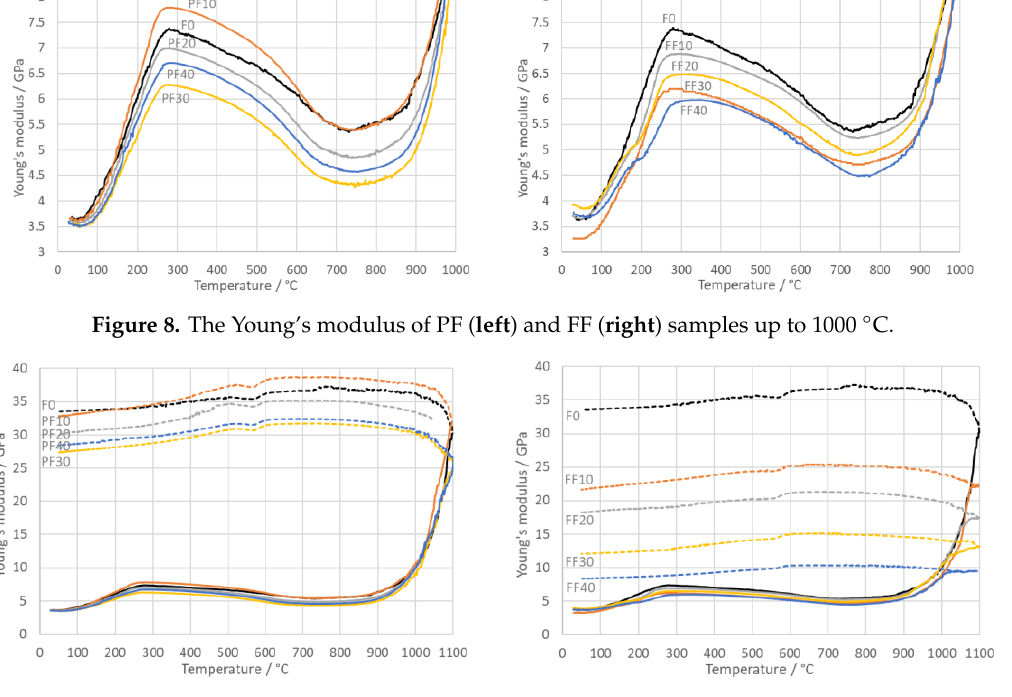
Minerals 2020 , 10 , x FOR PEER REVIEW 8 of 12